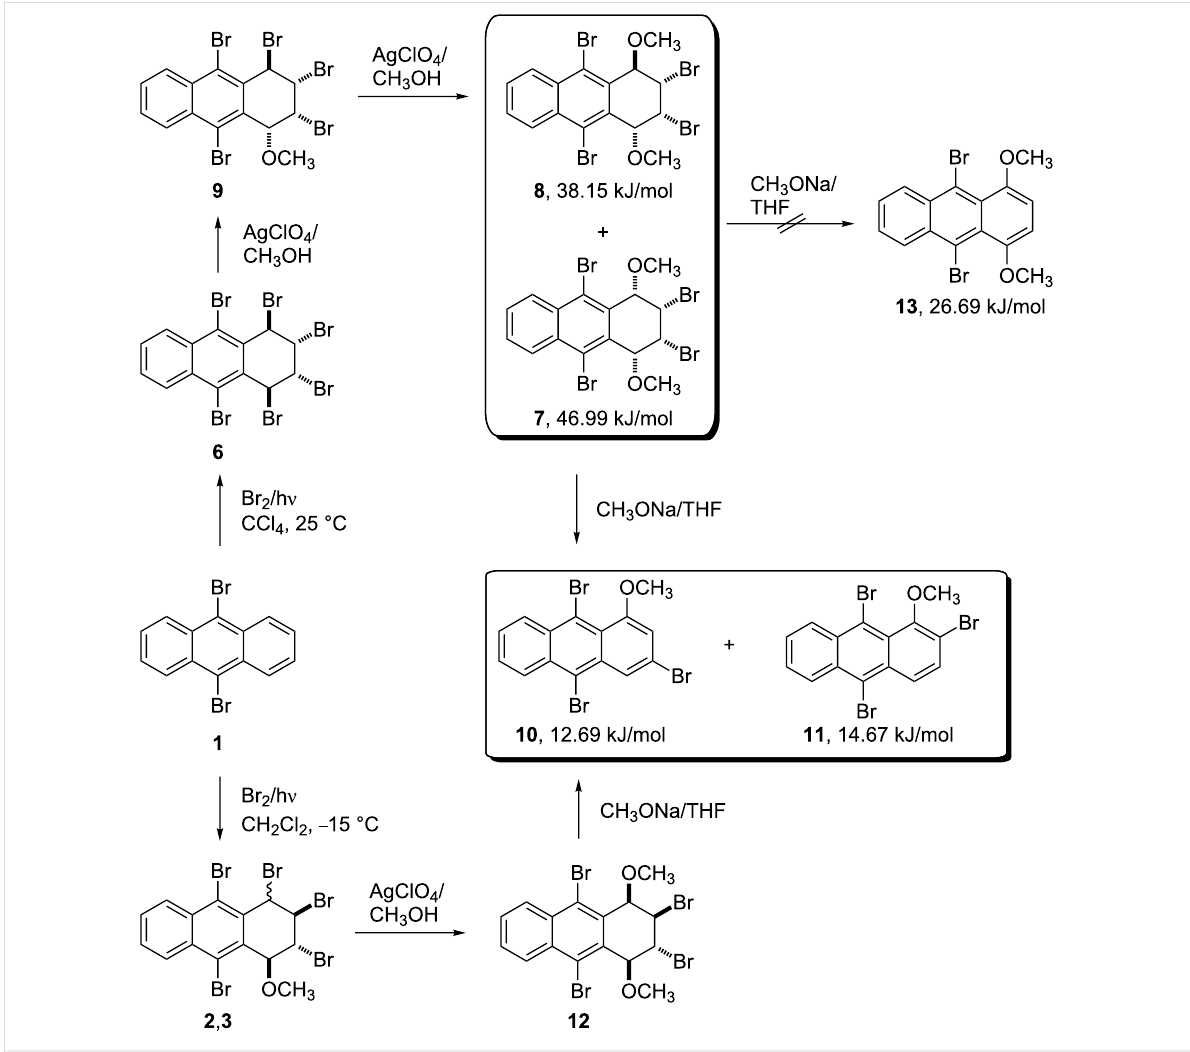
Scheme 2: Synthesis of methoxyanthracenes 10 and 11